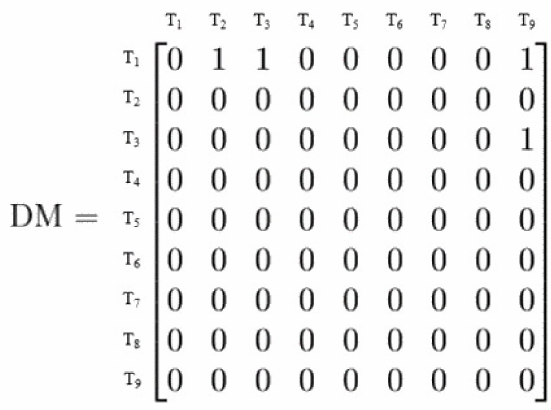
Figure 17. Dependency Matrix (DM) for the example